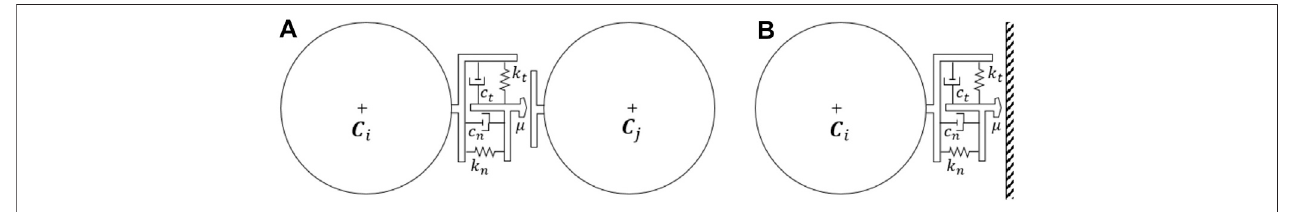
FIGURE 2 | (A) DEM-DEM rheological model adapted from Santasusana (2016). (B) DEM-FEM rheological model adapted from Santasusana (2016).